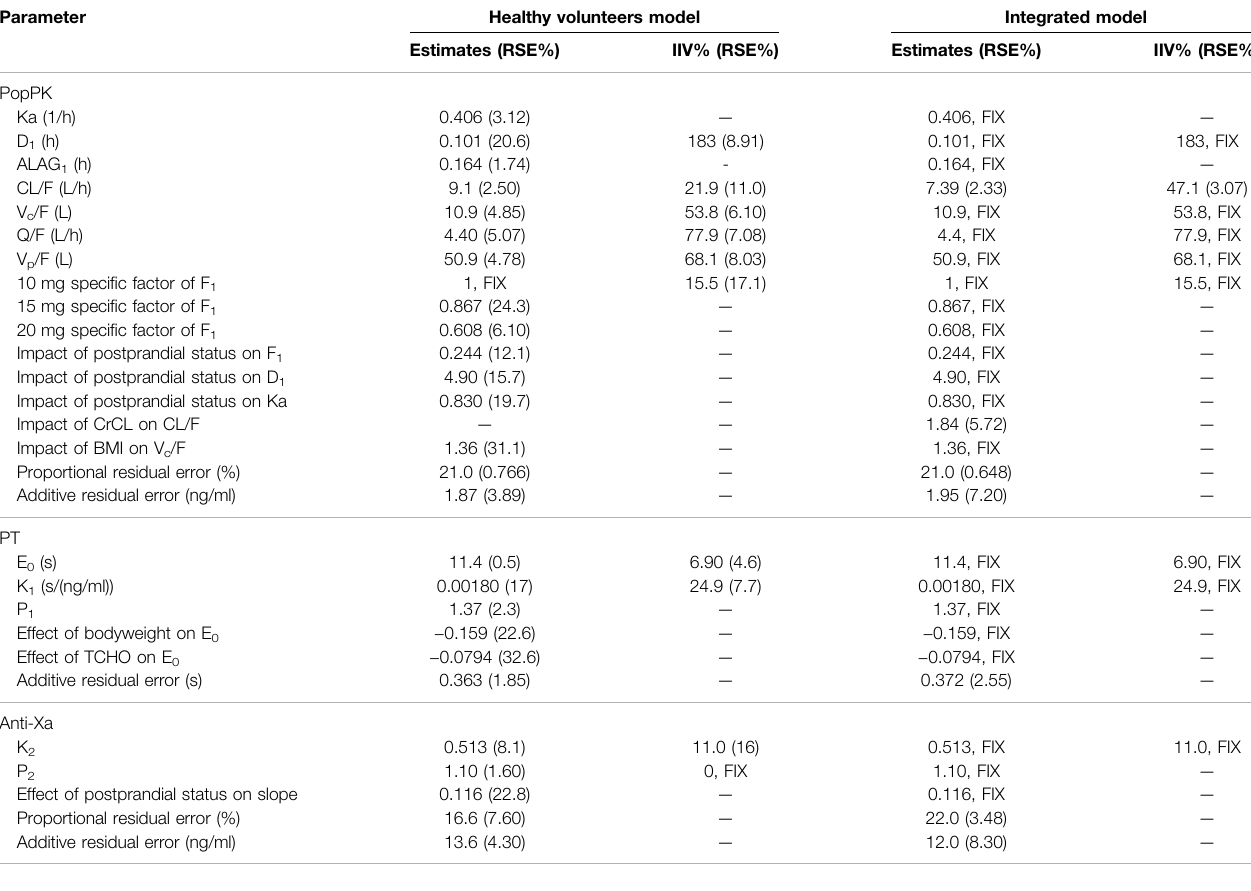
TABLE 2 | Final population estimates for parameters of healthy volunteers model and integrated model.